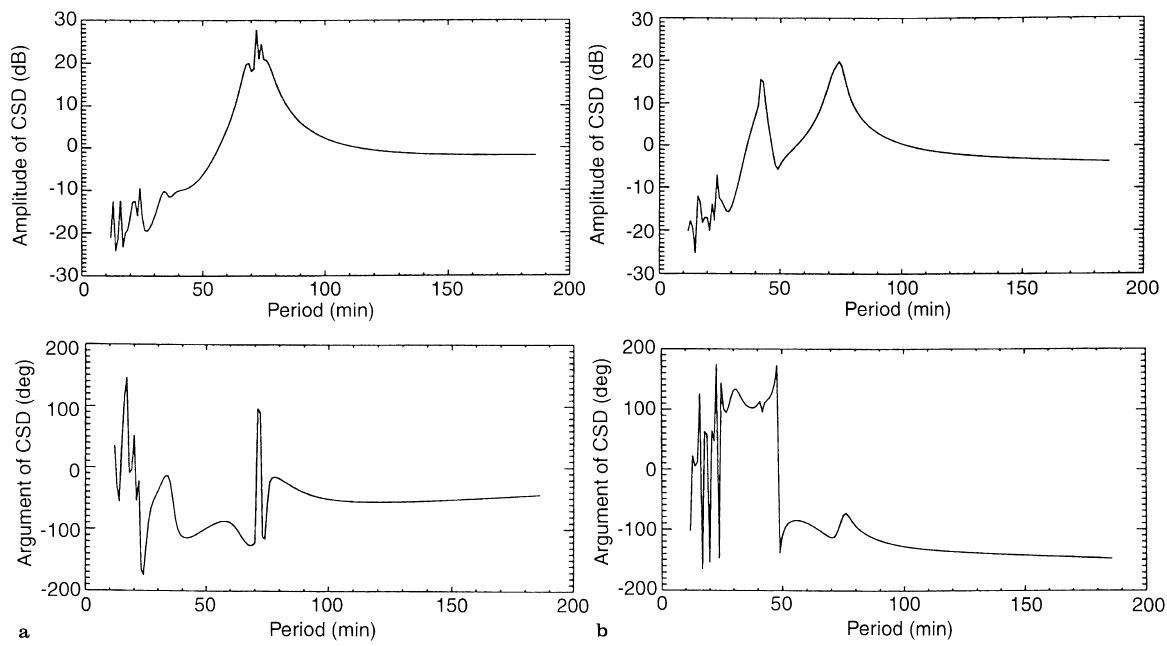
sinusoidal waves with periods of 42min and 72min superimposed on a Gaussian random series. The phases of the two sinusoidal wave pairs are 90 (cid:14) and ) 90 (cid:14) ,